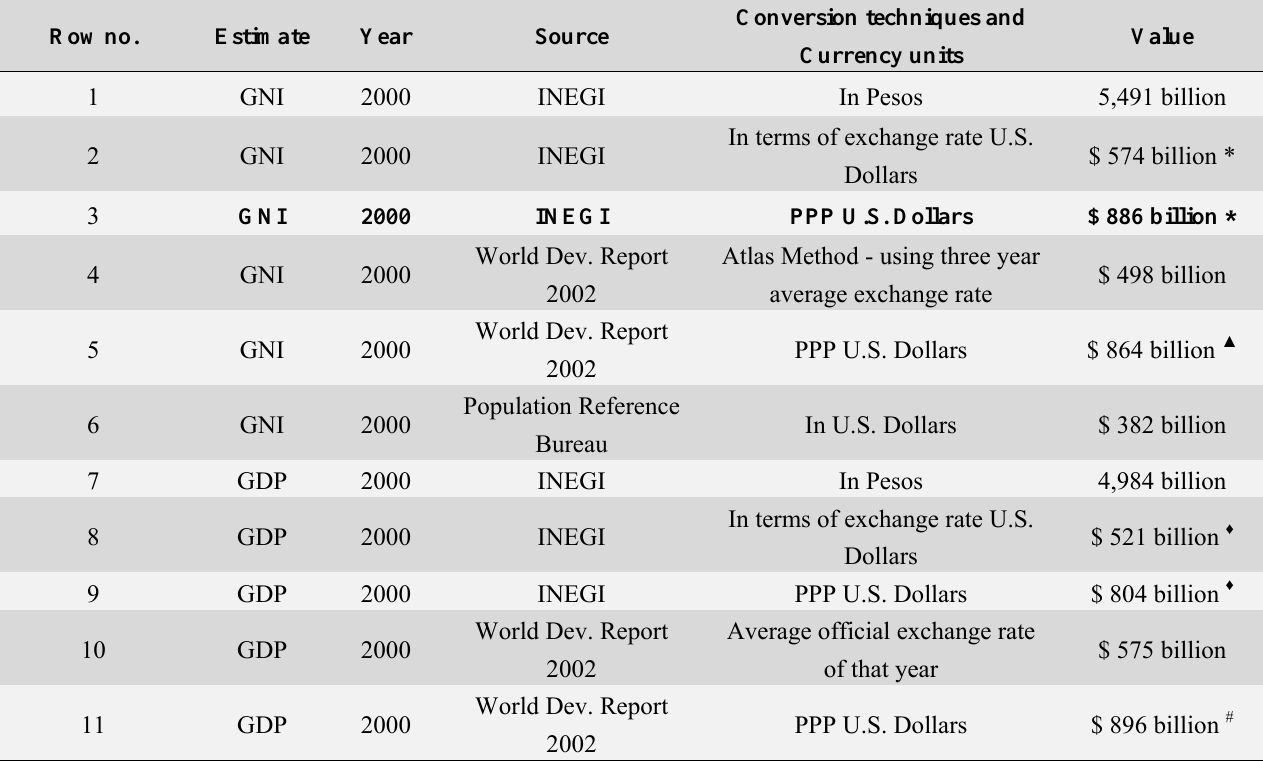
Table 2. Comparison of the GNI and GDP estimates of Mexico from different sources. Row no.